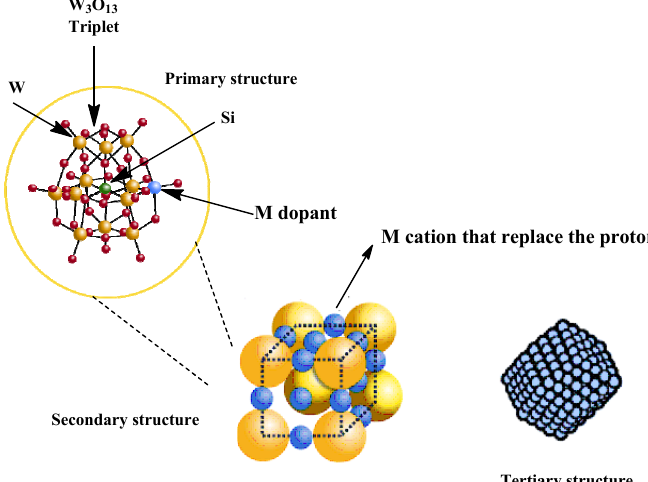
Figure 5. Primary, secondary, and tertiary structures of Keggin anion. The Bragg equation describes the relation between interplanar distance “d” and scat- tering 2 θ angles. sin θ = n λ / 2d (1) An increase in metal cation radium led to a greater “d” value, consequently, it is ex- pected that 2 θ angle values become smaller than sca tt ering angles of pristine HPA. How- ever, this distance is impacted too by the water molecules. Therefore, ionic radium is not the only aspect to be considered. Figure 6 presents the powder XRD pa tt erns of silicotungstic acid and their metal- exchanged cations. Di ff ractograms of the metal cation-exchanged silicotungstic acid salts have some typical di ff raction peaks. The main appears at low 2 θ angles (i.e., 6° to 9°), 15° and 30° 2 θ angles. In particular, the di ff ractograms of trivalent cation salts (i.e., Fe 3+ , and Al 3+ ions) have more well-de fi ned and more intense di ff raction peaks. The di ff erences ob- served between XRD pa tt erns of silicotungstic acid, and their metal-exchanged salts can be a consequence of di ff erent hydration levels (Table 1), as well as the di ff erent sizes of ionic radium of metal cations. 5